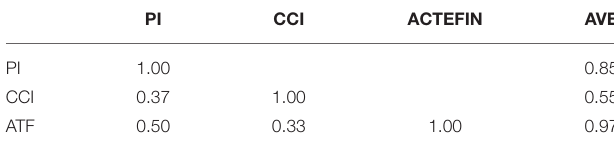
TABLE 1 | Study 1. Results of the CFA. TABLE 2 | Discriminant validity.